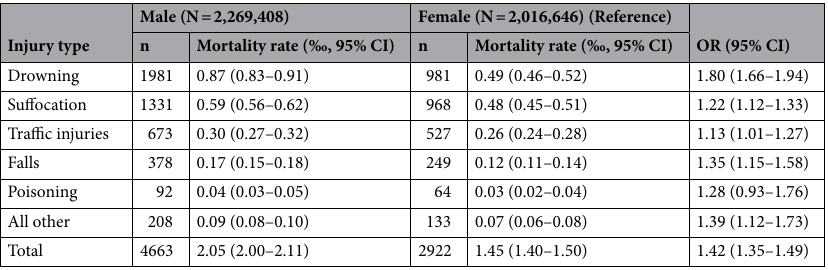
Table 6. Injury-related under-five mortality rate by gender. N number of live births, OR crude odds ratio, CI confidence interval.